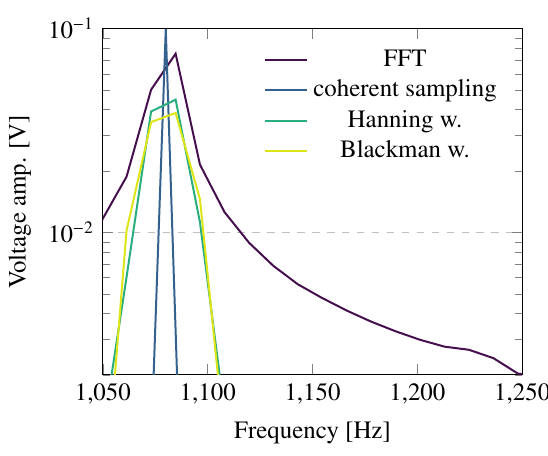
Fig. 2. Processed data, peak value detail .